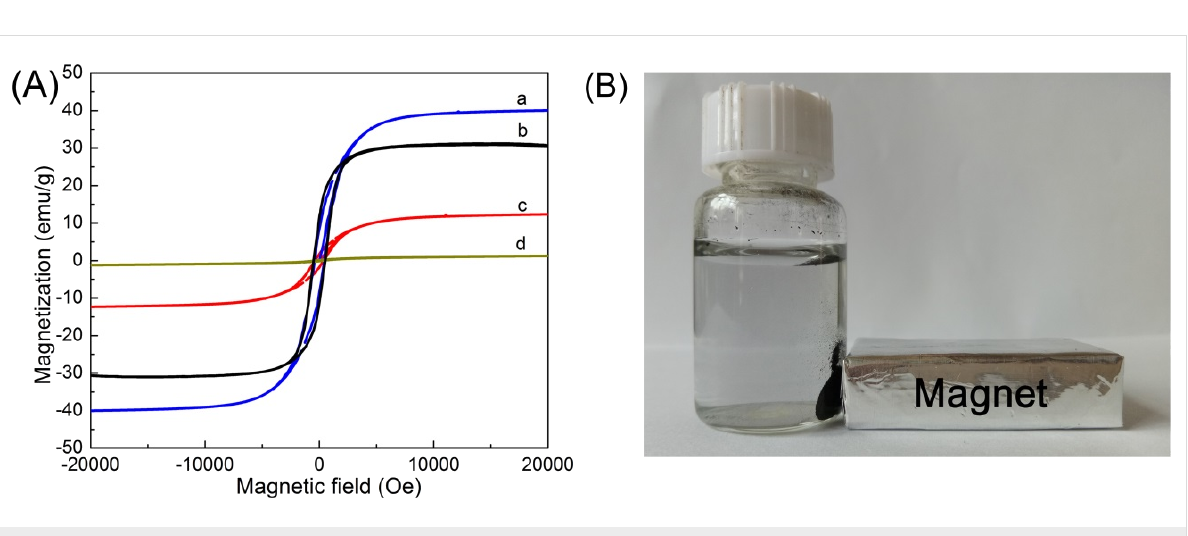
Figure 5: (A) Magnetization curves of the nanoplate samples prepared by carbonization of LDH@PDA at (a–c) 800 and °C (d) 650 °C for 2 h. LDH@PDA composites were prepared with different initial dopamine hydrochloride concentrations of: (a) 2.0, (b) 2.5, (c) 1.0 and (d) 2.5 g/L. (B) A photograph illustrating the physical separation of the adsorbent material (NPLs-2.5-800) from water in the presence of an external magnetic field (permanent